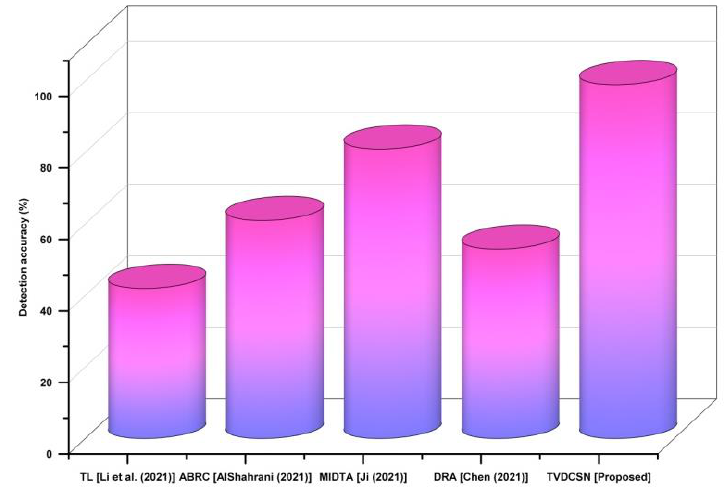
Table 1. Values of proposed and existing methods of detection accuracy.